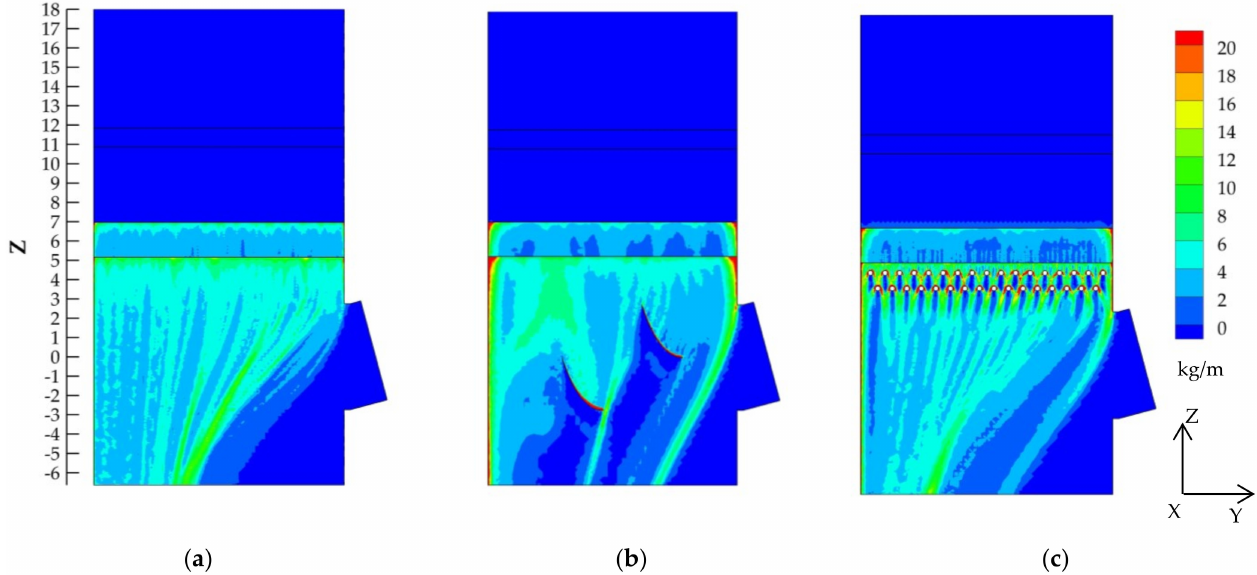
Figure 7. Liquid mass concentration: ( a ) OST; ( b ) DST; ( c )